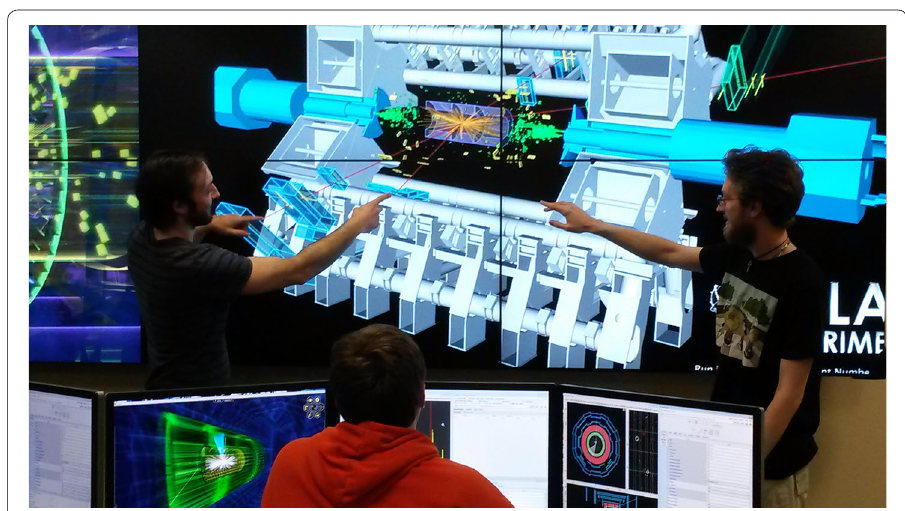
Fig. 25 Students interacting with the high-resolution image displayed on the Hiperwall to determine and identify the specific particle tracks from the decay of the Higgs Boson from an ATLAS Event